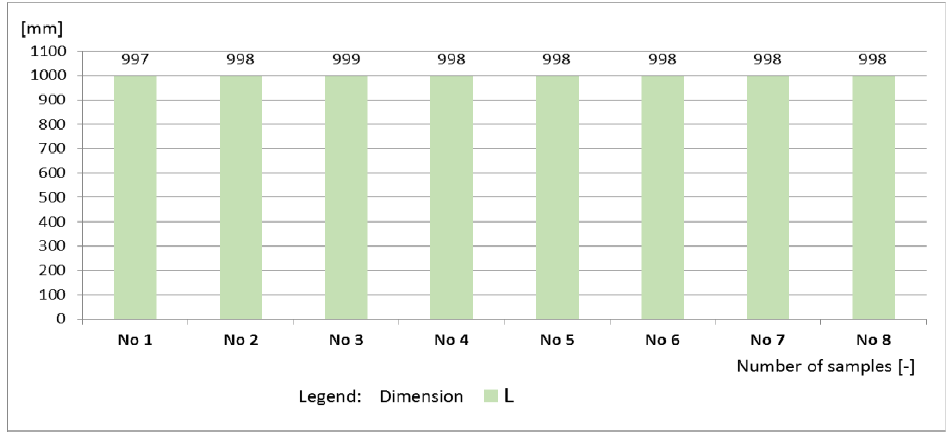
Figure 16. Values of L of the tested curbs.